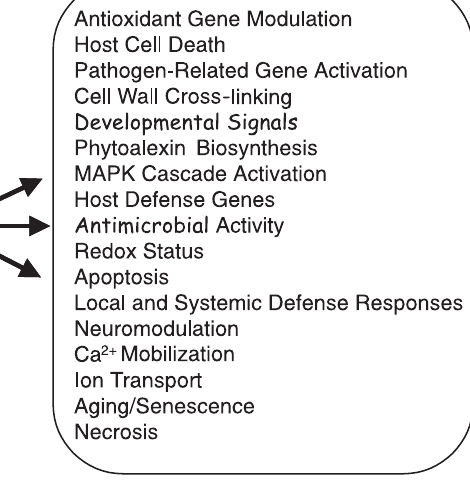
Figure 7. Scheme showing some of the useful pleiotropic roles of reactive oxygen species (ROS) known to occur in most higher organisms, indicative of the fact that ROS are not always harmful to cells. MAPK = mito- gen-activated protein